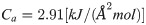
Temperature factors obtained with the AAENMs and crystal structure analysis.(a) Temperature factor of each atom (TF
i) and (b) average temperature factor of the motifs (MATF
i) obtained by the AAENMs (black curve) and crystal structure analysis (CSA, gray (red) curve) of typical double-stranded DNA (PDB ID: 1BNA). Here, Ca=2.91[kJ/(Å2mol)], B
B = 0.018, and B
W = 0.02. Atom and motif indices in (a) and (b) are given in the same order as shown for (c). ρ indicates the Pearson correlation coefficient of the profiles between the two curves.